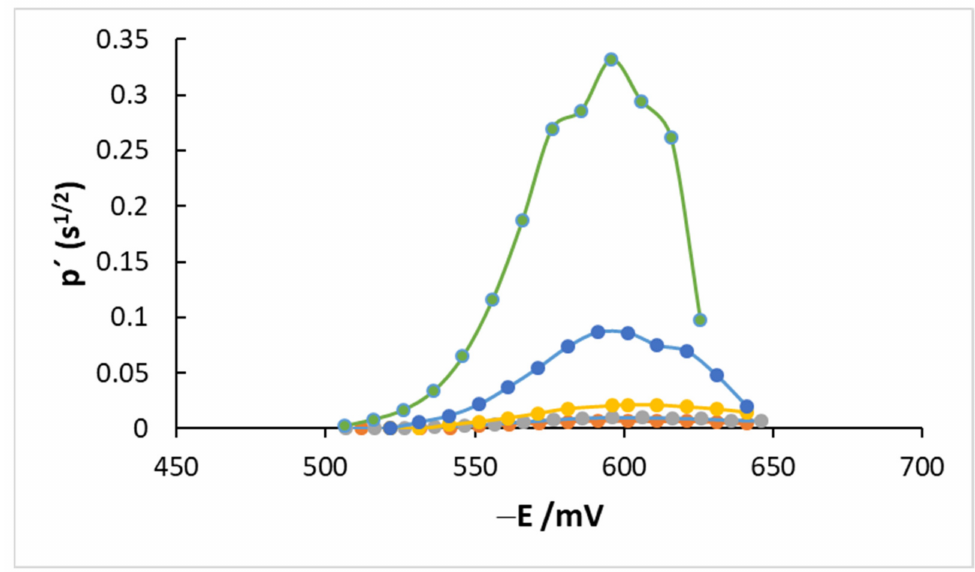
Figure 4. Plot of the irreversibility quotient p (cid:48) vs. E at different TEA concentrations. TEA concentra- tions (mM): 0 (orange), 0.75 (grey), 2 (yellow), 5 (blue), 10 (green). From the expression of p (cid:48) (Equation (6)), we can see that the plot of p (cid:48) vs. E (Figure 4) presents a maximum, predicted by Equations (7) and (8). Table 3 presents the values of p (cid:48) at the maximum. The maximum of p (cid:48) is shifted to more negative potentials, which means, according to Equation (7), that α < 0.5. From Equation (7) and E 1/2r , we obtain α ap = 0.11, and from Equation (6), values of K can be obtained. In Table 3, the values of K at the formal potential are shown (K f ). Values of α between 0.1 and 0.25 in perchlorate medium have been reported, but in some cases, values of α = 0 or 0.68 have also been